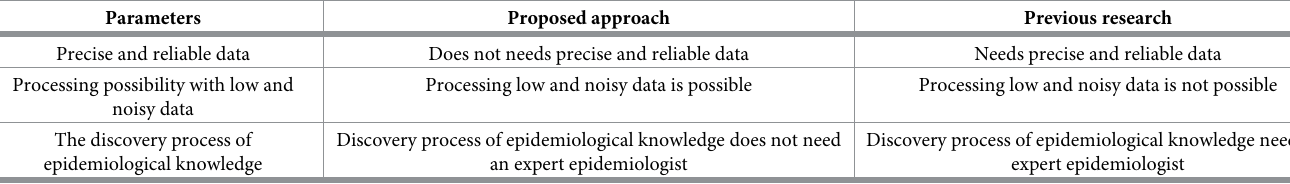
Table 15. The superiority of the present study’s method compared to the other